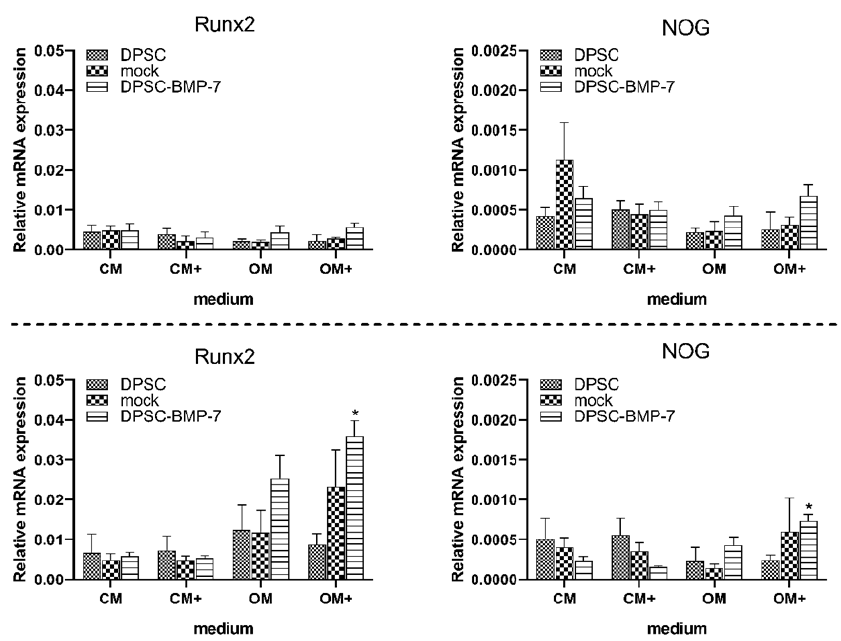
Figure 3. Expression level of Runx2 and noggin (NOG) mRNA in case of the indicated cell lines. After 1 week (above) and 3 weeks (below) of induction in different media (mean ± SD; n = 3). *, p ˂ 0.05 vs. control (DPSC) in the same media, #, p ˂ 0.05 vs. untreated (CM or OM respectively) group of the same cell line.